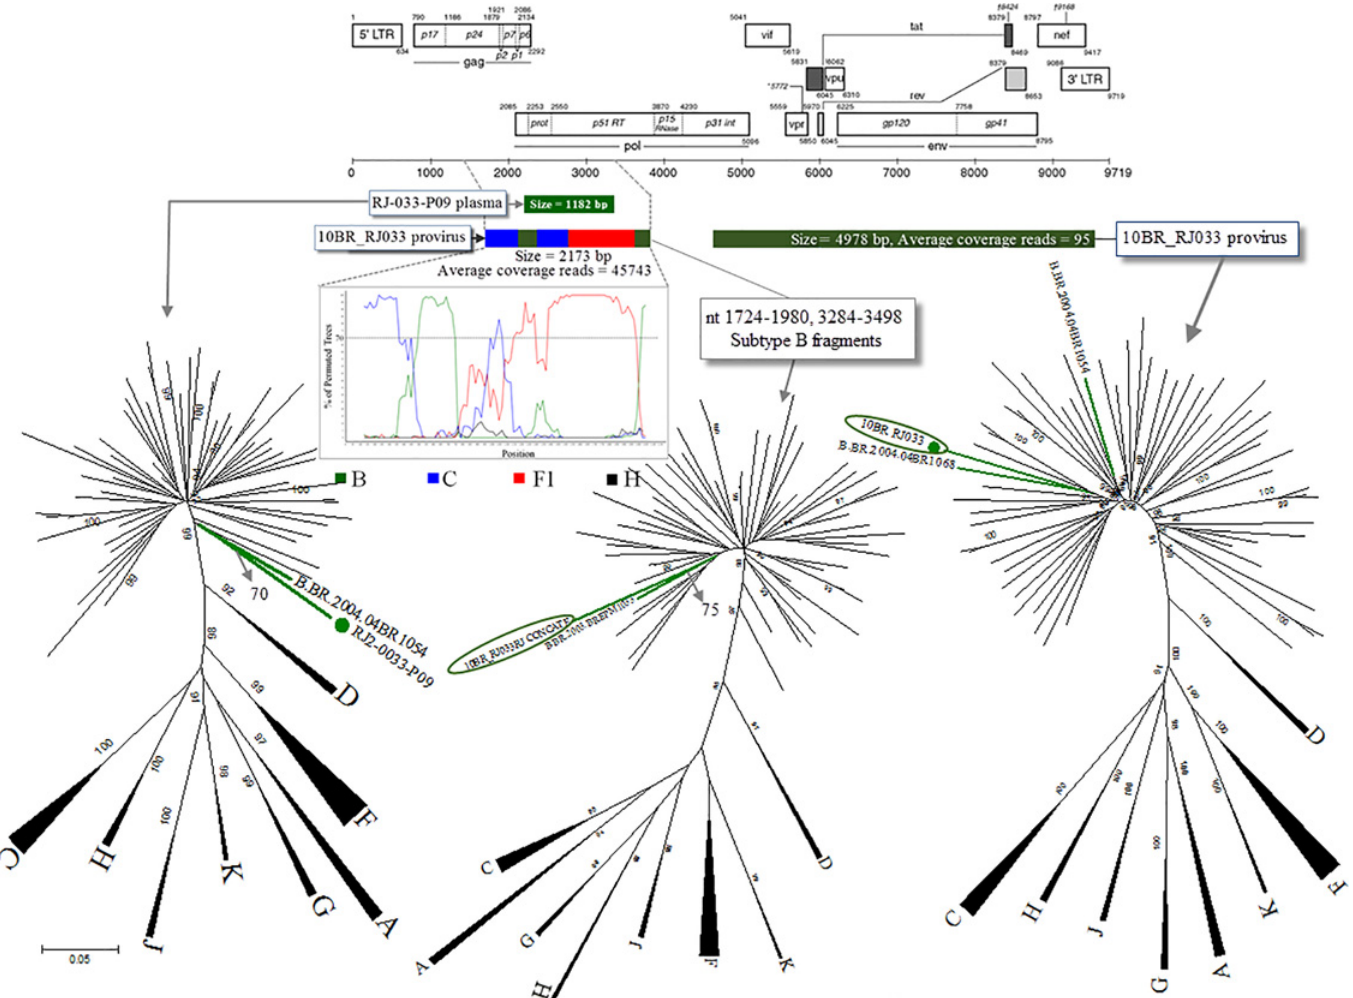
Fig 4. Phylogenetic trees were constructed using a maximum-likelihood method from partial pol plasma RNA virus (1182 bp), concatenated regions of subtype B sequences (provirus nt 1724 – 1980, 3284 – 3498) and proviral DNA (4978 bp fragment) from patient 010BR_RJ033 along with 53 non-redundant Brazilian subtype B and HIV-1 reference sequences from the Los Alamos HIV-1 database representing 11 genetic subtypes. The recombinant proviral fragment (2173 bp) is evidenced by a Bootscan plot. Average coverage reads of both proviral fragments are